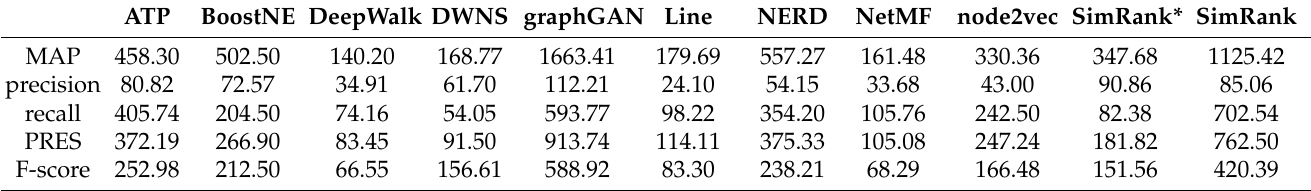
Table 13. Accuracy improvements (%) by JacSim over other methods with the Wikipedia